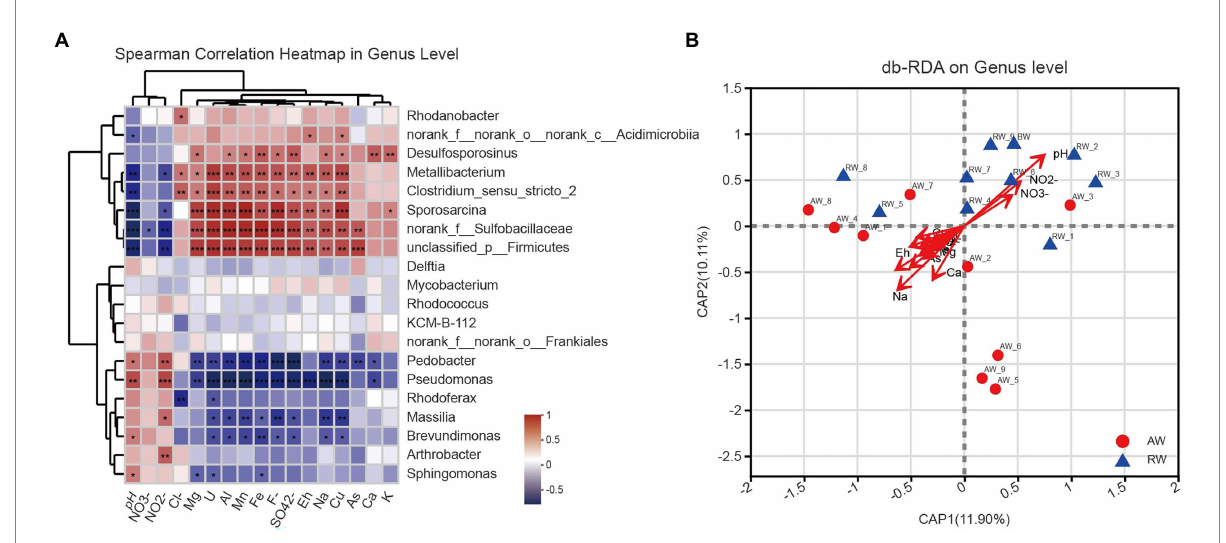
FIGURE 8 (A) Heatmap of spearman correlations between the relative abundance of the top 20 dominant bacterial communities and environmental factors at genus level. The x -axis and y -axis are environmental factors and taxa, respectively, and the spearman correlation R value and p -value are obtained by calculation. Red represents positive correlations between the microorganisms and the variables while Blue represents negative correlations. The R values are shown with different colors and the p -value less than 0.05 is marked with (*0.01 < p < 0.05, **0.001 < p < 0.01, *** p < 0.001). Note that NO3-, NO2-, Cl-, F-, and SO42- represent 0 3 N − , 0 2 N − , Cl − , F − , analysis (db-RDA), derived from the Bray–urtis distance in genus level, represents the relationship between community structures and the environmental factors that influence them.